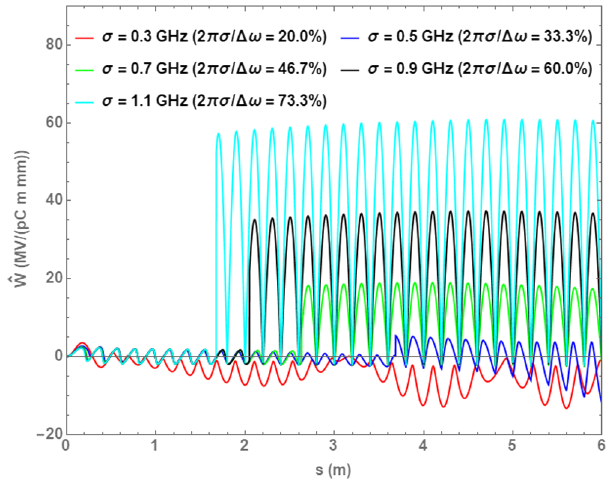
FIG. 28. The difference between the summation method (25) and the analytical expression (28) for a Gaussian structure of fixed Δ ω = 2 π ¼ 1 . 5 GHz and L ¼ 0 . 5 m, over a range of σ .